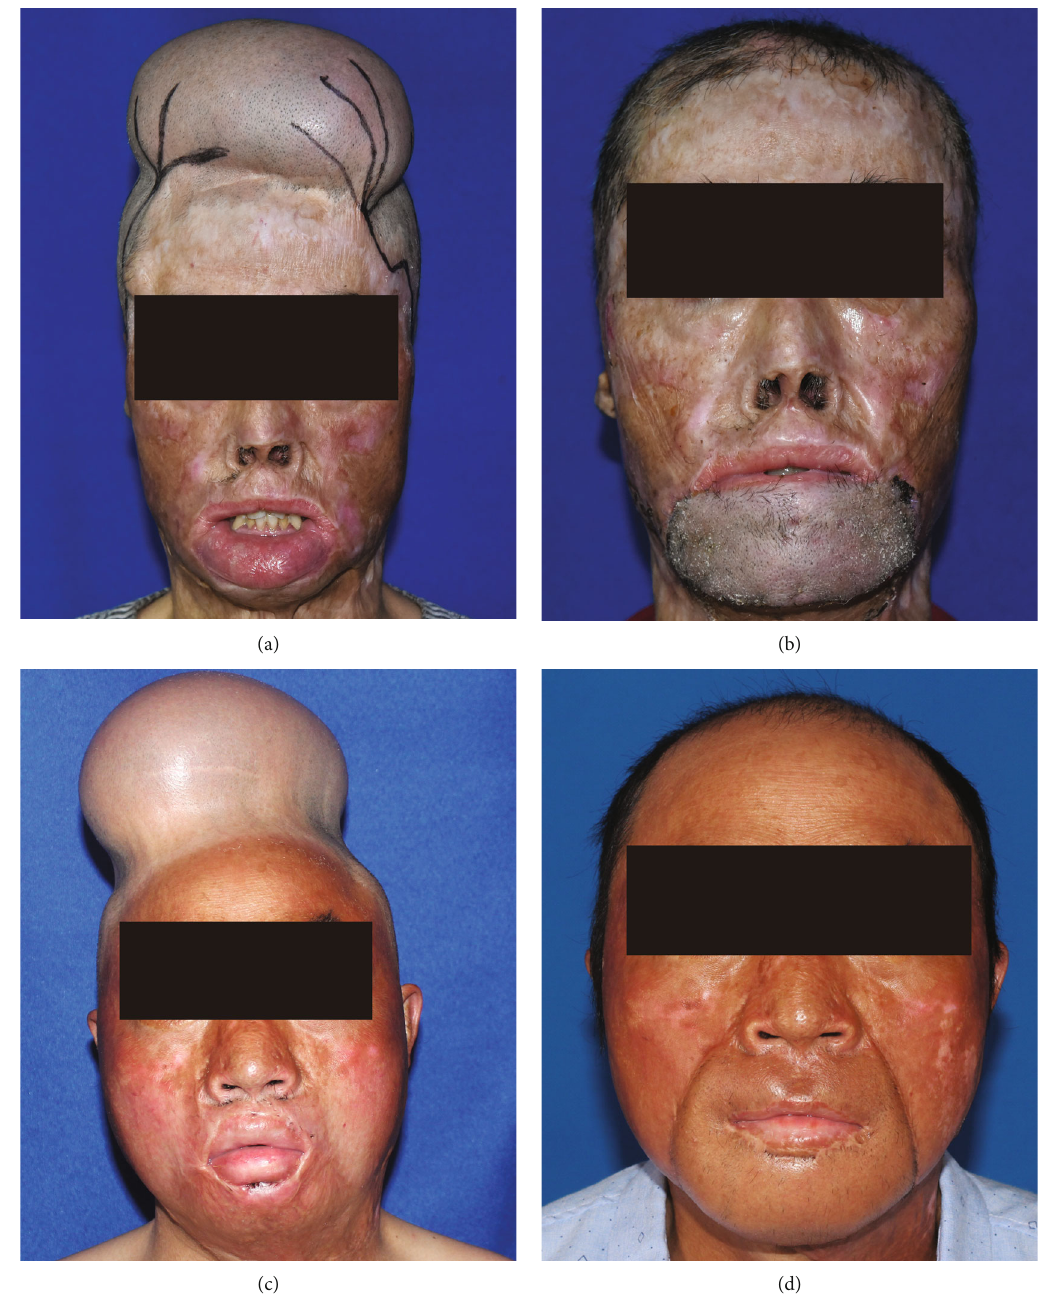
Figure 3: (a – d) The patient ’ s appearance before fl ap transfer with the tissue expander implanted and 6 months after pedicle division,